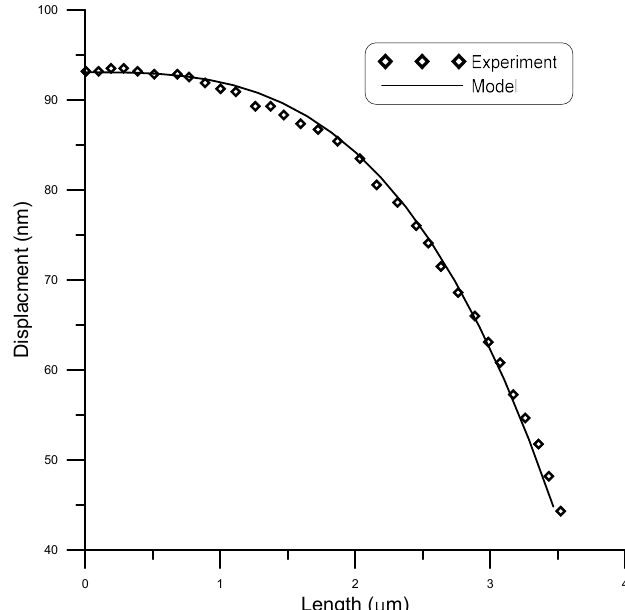
Figure 12. Displacement of a 3.6 µ m long beam of circular cross-section of 120 nm diameter under point load of 6.6 nN, compared to experimental data [25].